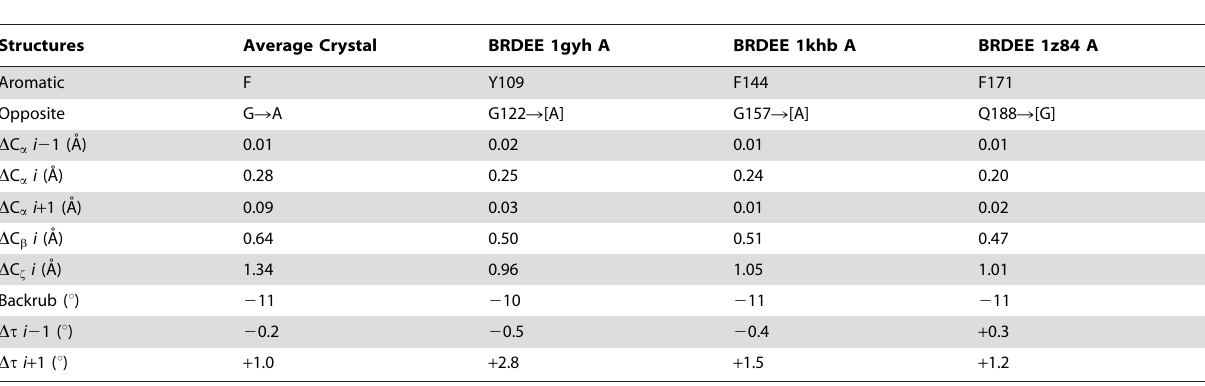
Table 2. Backrub changes at b aromatics across from Gly vs.